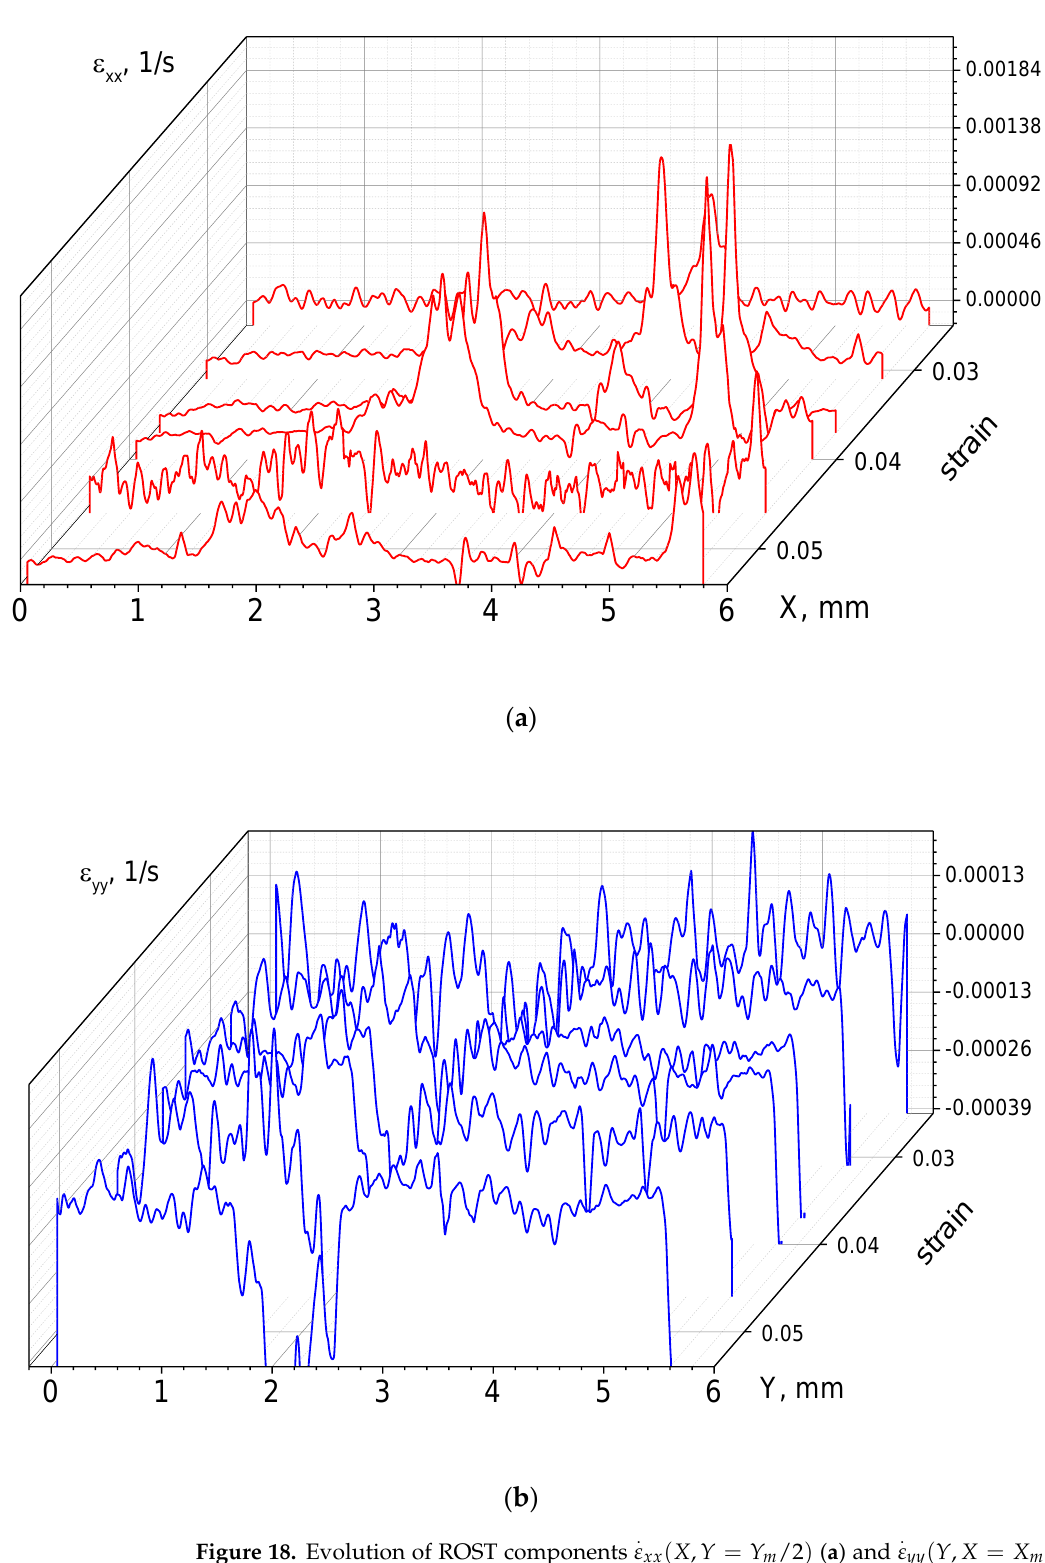
Figure 18. Evolution of ROST components from Sample #1 are shown.